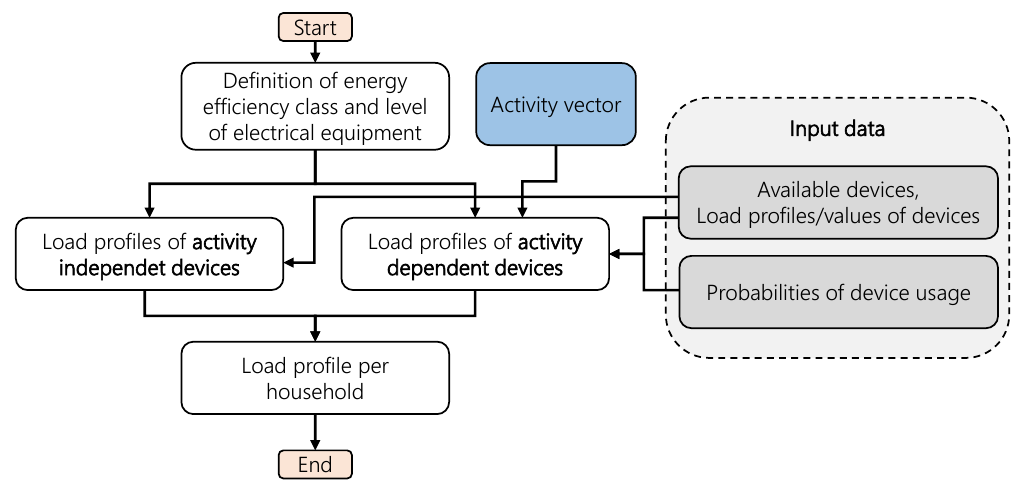
Figure 3. Flow chart of the electrical